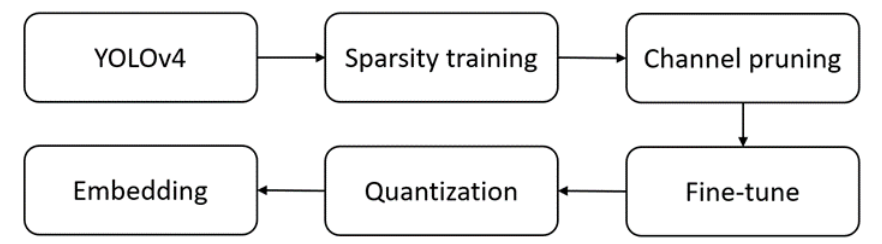
Figure 2. Process to port YOLOv4 to an edge device.